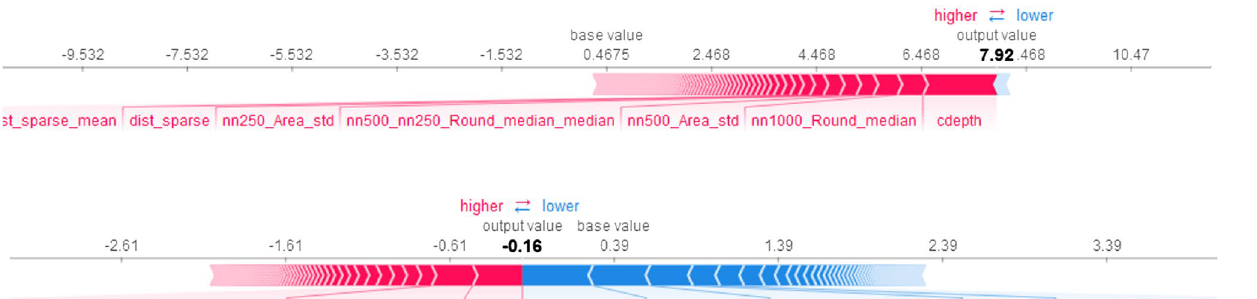
Figure 8. Contribution of different features for predicting a neuron’s layer can be analyzed at the instance-level, for each individual neuron. Top: neuron features of a single neuron of layer III that contributed to the increase from the base SHAP value and making the prediction. Bottom: the importance of features that decreased the output value for prediction of the same neuron as a layer II